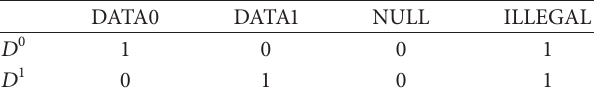
Table 1: Dual-rail signal representation.